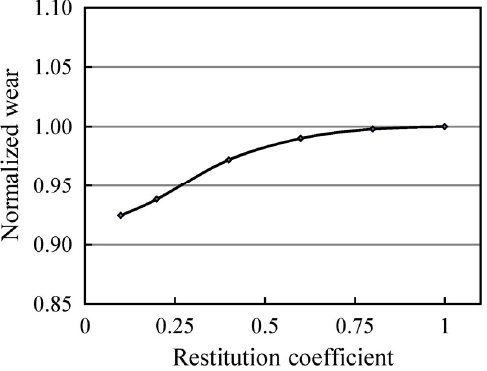
Fig. 8 Variation of the wear versus the restitution coefficient ( 50  ° and the other variables are at the reference values).